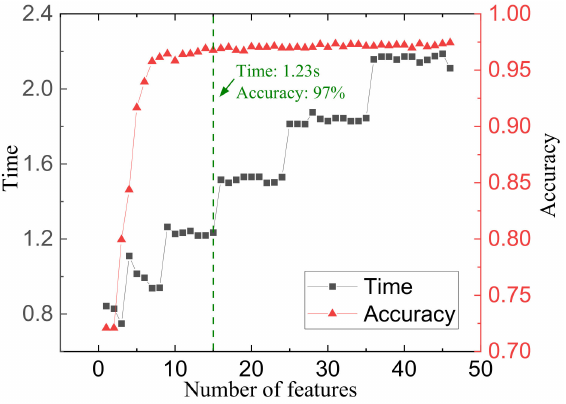
Figure 14. The impact of changing the number of features